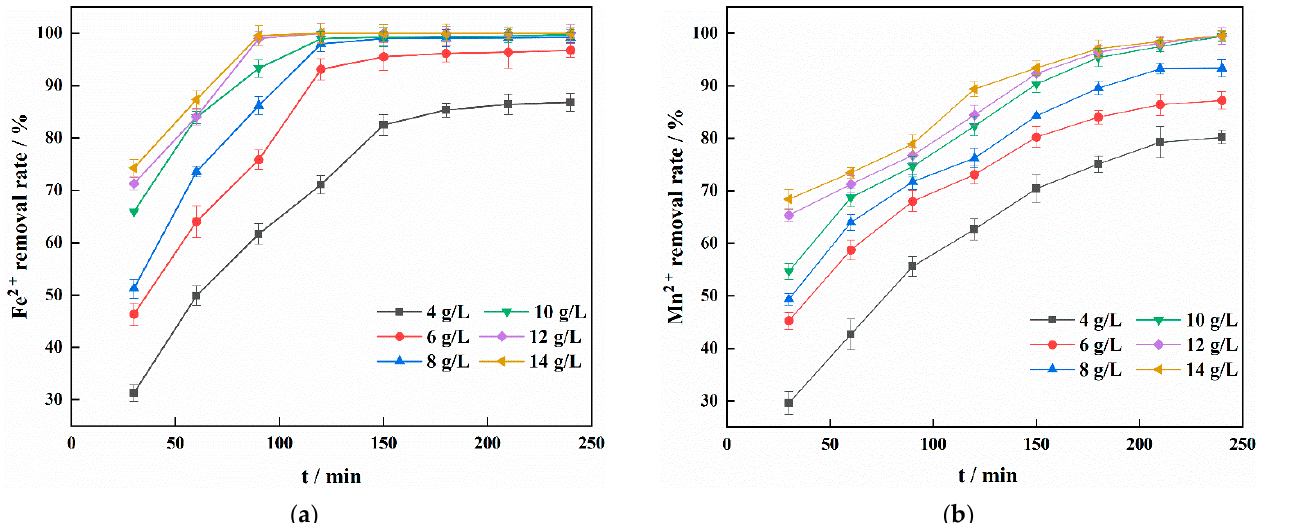
Figure 2. Effect of different doses on the removal of Fe 2+ ( a ) and Mn 2+ ( b ).